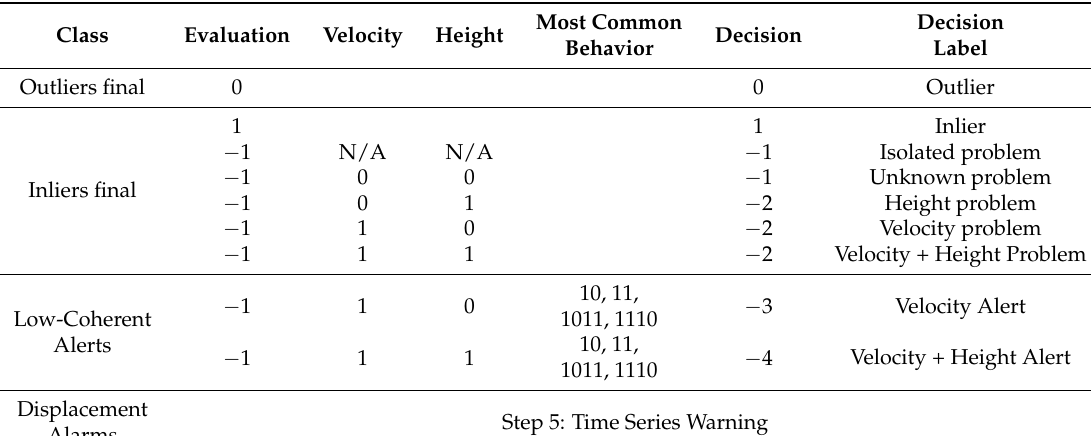
Figure 5. Classical and robust confidence ellipse [67]. Table 3. Rejection table: Variables and classes produced for Level 3 product